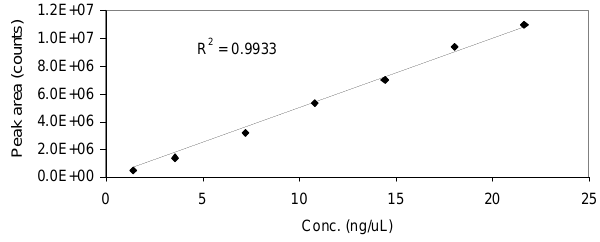
Fig. 2. Example of GC-MS calibration for